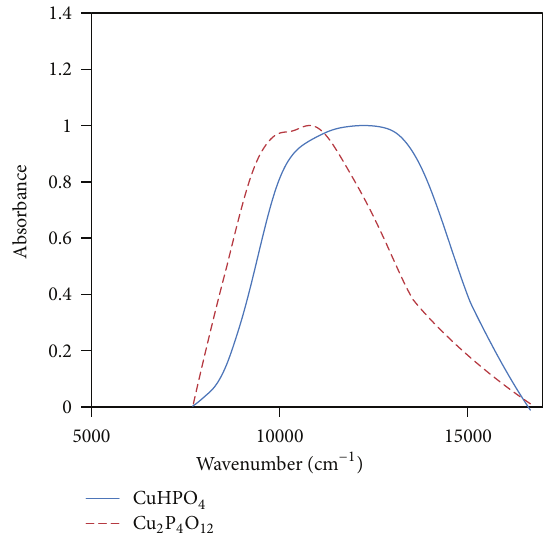
Figure 2: Absorbance spectra of CuHPo 4 and Cu 2 P 4 O 12 .